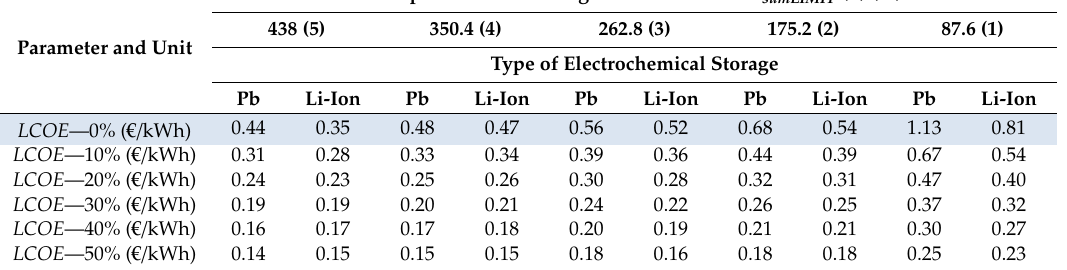
Table 9. Comparison of optimization results ( LCOE ) of a structure of a PV-wind hybrid power supply system for a 50 kW peak power communal load and Pb and Li-ion batteries (current parameters and prices), for the cases of using 10, 20, 30, 40 and 50% of the energy emitted on the heaters during heating of facilities.